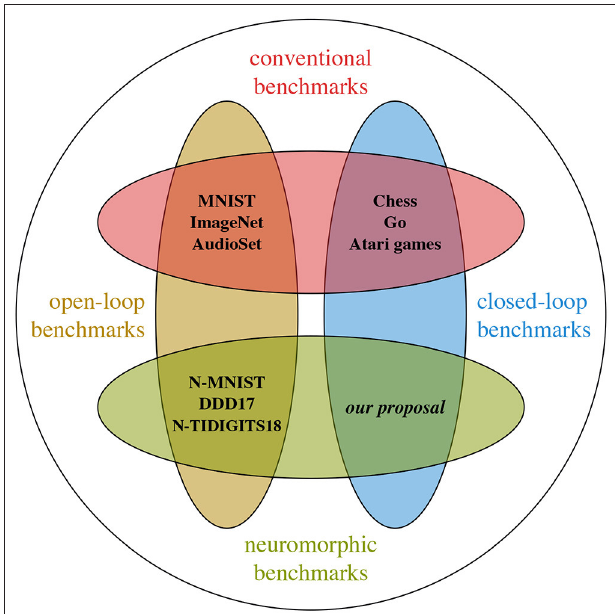
FIGURE 2 | Existing datasets and benchmarks fall into two categories: open-loop benchmarks, or datasets, and closed-loop benchmarks. Supervised machine learning relies mostly on the first category, whereas reinforcement learning requires the second. Most existing neuromorphic engineering benchmarks fall in the first category. This article pleads in favour of closed-loop neuromorphic